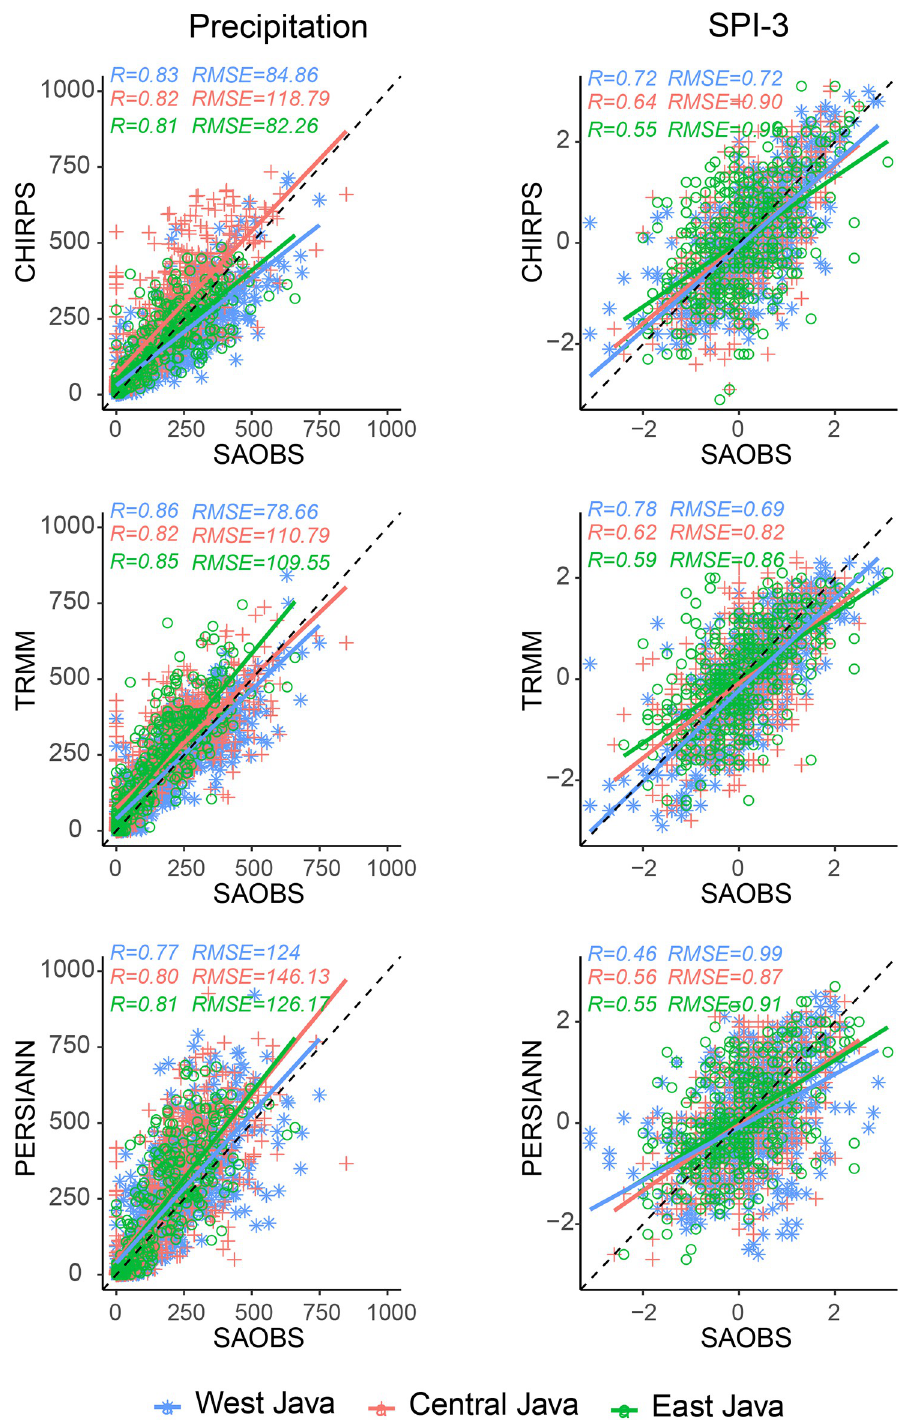
Fig 6. Scatterplot of the regional pooled precipitation (left) and SPI-3 (right) for 2001–2017. CHIRPS, TRMM, and PERSIANN were each plotted against SA-OBS.